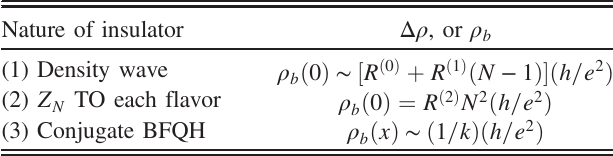
TABLE I. Summary of resistivity for three scenarios considered in this work. TO is topological order. Nature of